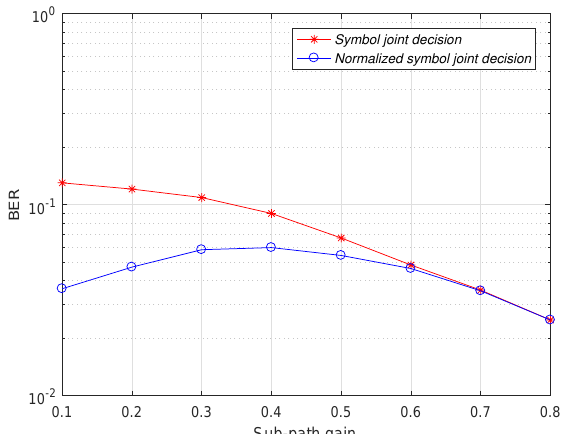
Figure 9. Bit error rate comparison of normalized symbol joint decision and symbol joint decision after fixed main path